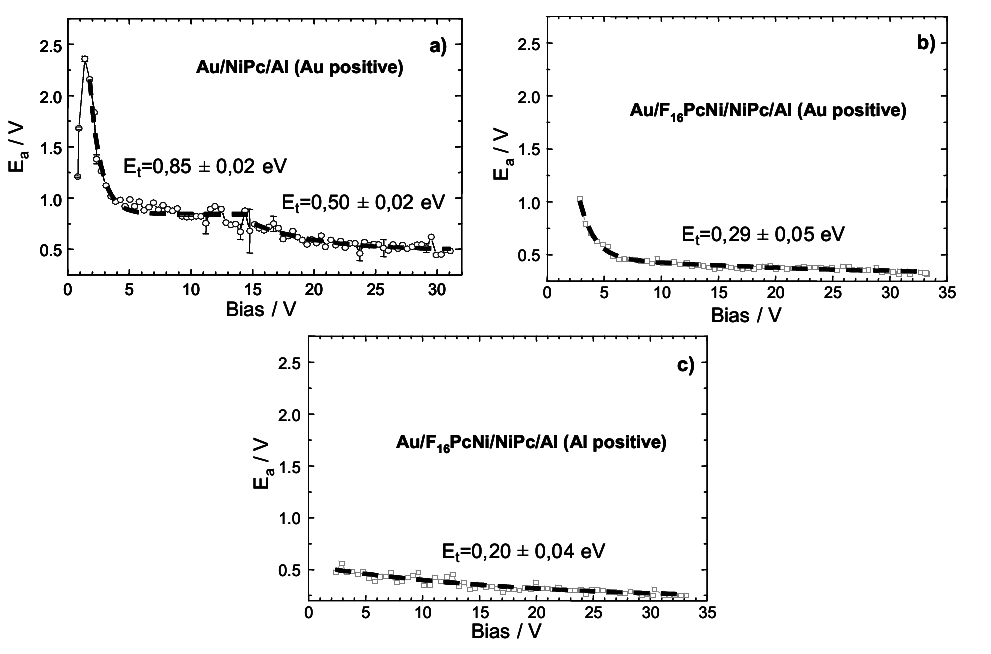
) on the applied voltage for the Au|NiPc|Al sample, with a Pc)|Al structure, with Au (b) and Al (c) as positive 16 electrodes,